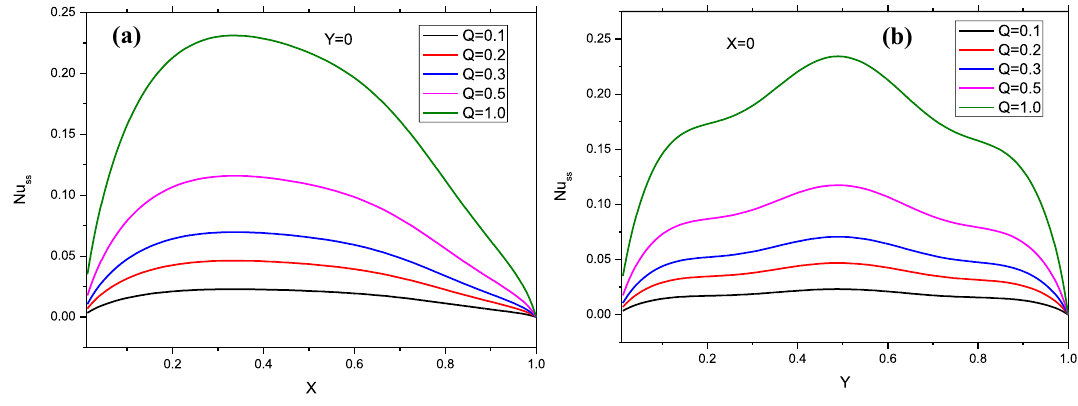
Fig. 6 Heat generation heat transfer parameter profiles of the local Nusselt number of solid phase for TiO Ha = 10 , Da = 10 – 3 , Ri = 1 , Gr